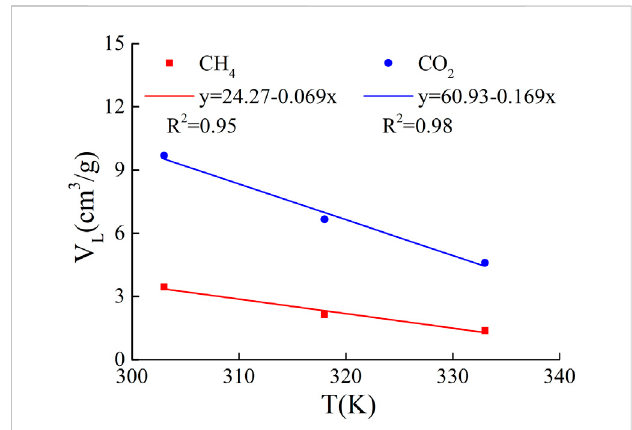
FIGURE 2 The relationship of Langmuir volume and